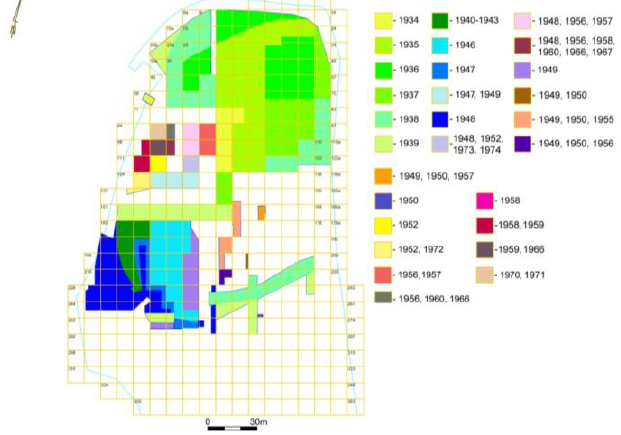
Figure 2: The area of archaeological works carried out